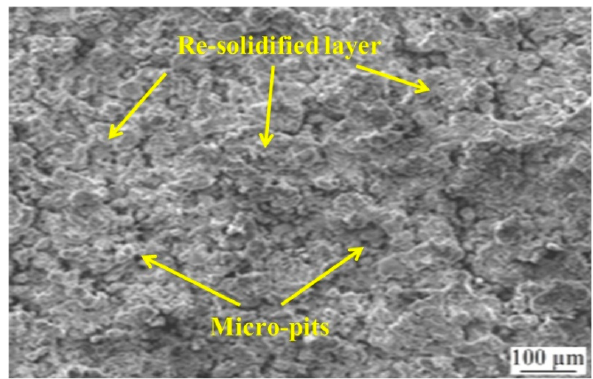
Figure 7. The machined surface corresponding to experiment number 25.